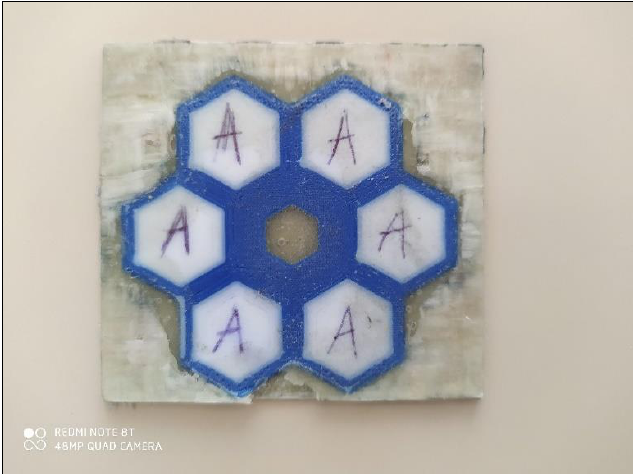
Figure 24. Panel K tested with the shear test.